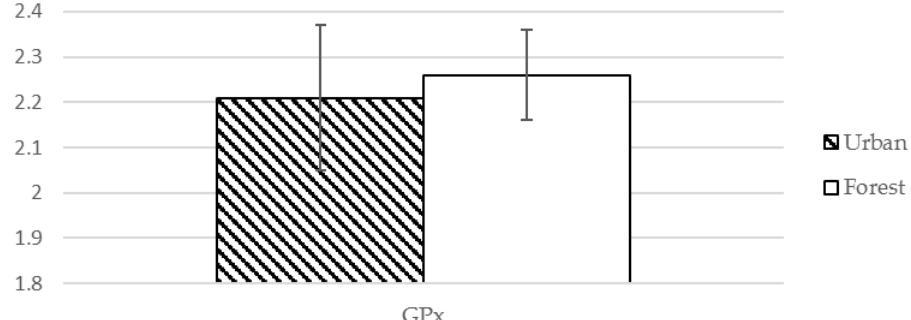
Figure 2. Effect of exposure to forest environment on GPx. Int. J. Environ. Res. Public Health 2016 , 13 , 625